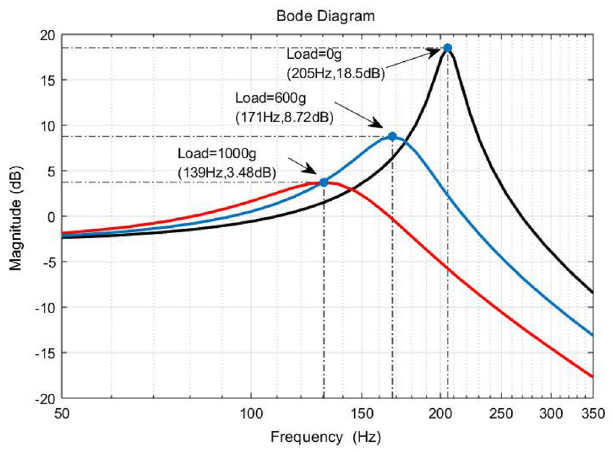
Figure 2. Open-loop Bode diagram of the system at mechanical loads of 0 g, 600 g and 1000